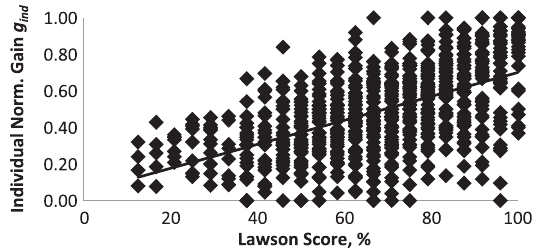
FIG. 5. Individual data for 803 students at Arizona School for the Arts, 2007 – 2018 ( r ¼ 0 . 55 ).